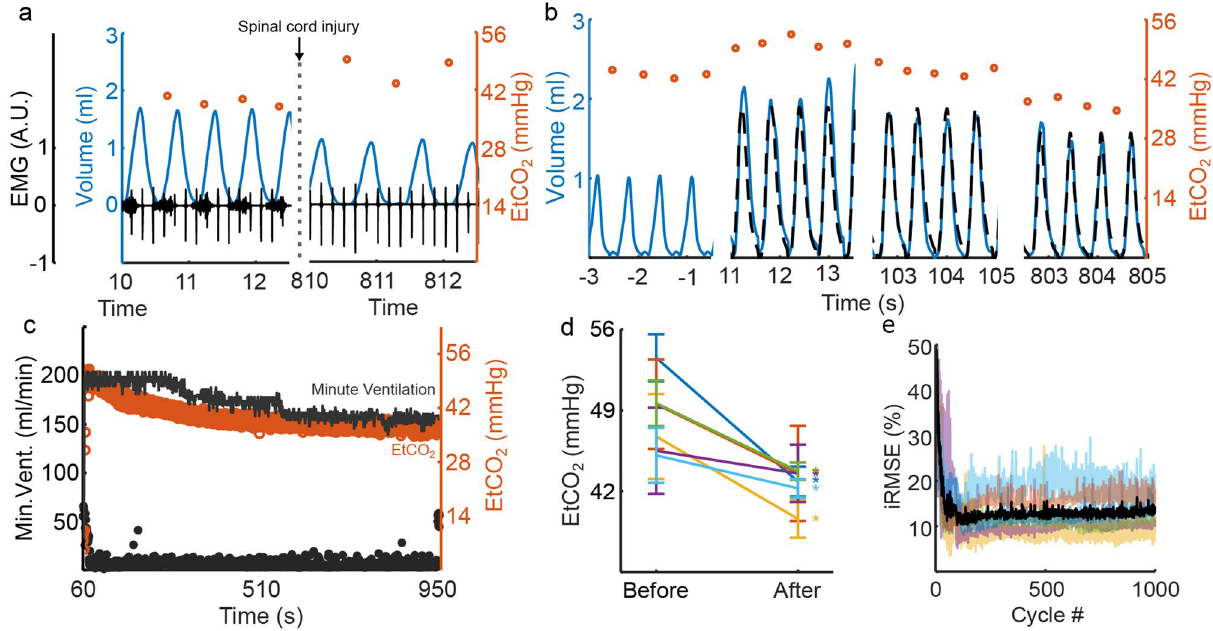
Figure 6. Adaptive PG/PS use in vivo after hypoventilation following C2 spinal cord hemisection. ( a ) Breath volume (blue), peak etCO 2 (empty circles), and diaphragm EMG (black) in rats with intact spinal cord (left) and after C2 spinal cord hemisection (right). Hemisection of the spinal cord at the C2 level leads to paralysis of the hemidiaphragm ipsilateral to the injury as seen by a lack of bursts of EMG activity following SCI. This leads to hypoventilation and consequently, to an increase in etCO 2 . Black spikes in the EMG trace reflect artifacts from cardiac activity. ( b ) After initiation, the adaptive PG/PS controller generates a desired ventilatory pattern (black, dashed line) with elevated breath volume and shorter breath duration due to elevated etCO 2 . The PS then attempts to match the measured volume (blue, solid line) to the desired ventilatory pattern. At 100 s, the PS was able to match the measured breath profile to the desired breath profile, consequently